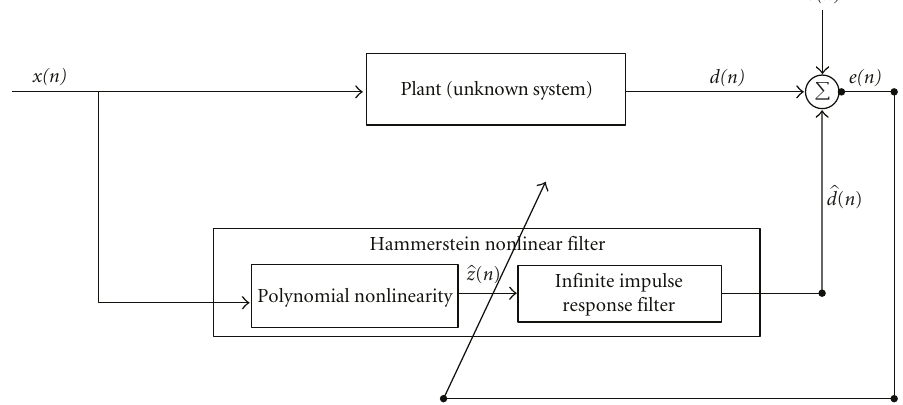
Figure 1: Adaptive system identification of a Hammerstein system